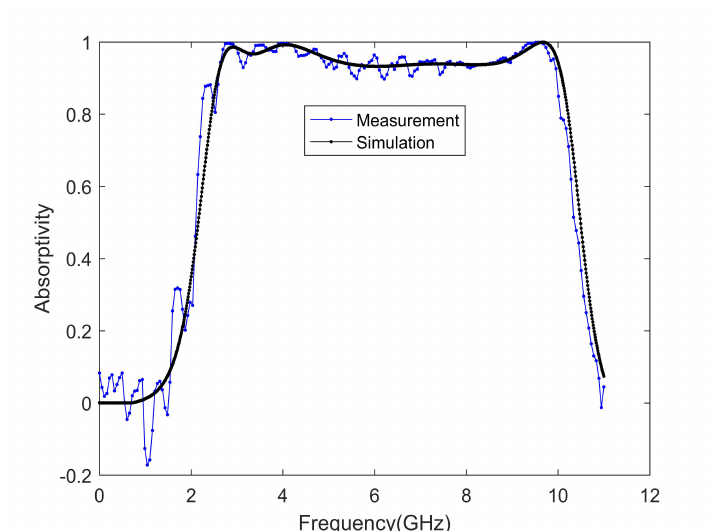
Figure 10. Comparison of the absorption rate between simulation and measurement.